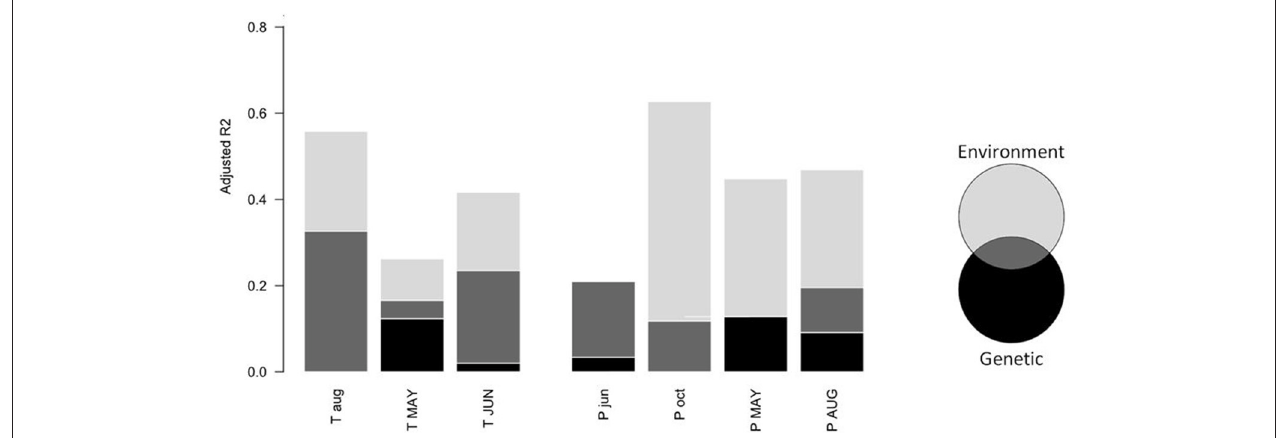
FIGURE 4 | Univariate variance partitioning between environmental variables (Equation 1) and genetic variables (Equation 2) to explain variability in growth-climate correlation coefficient among sites for each monthly climatic variable of Figure 2. Black bars represent the percentage of variance explained by genetic variables only, dark gray bars represent the variance explained jointly by environmental and genetic variables, and pale gray bars represent the variance explained by environmental variables only. The sum of the three represents the total variance explained by all the variables (Equation 3).